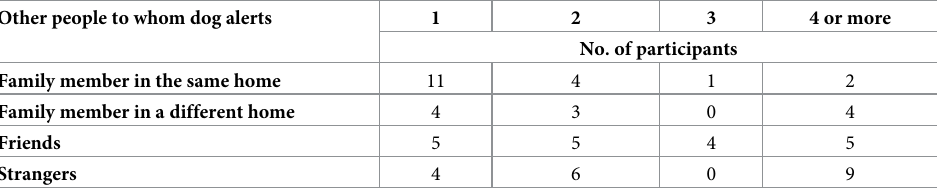
hyperglycaemia, p = .172, migraine, p = .270, seizure, p = .526, and POTS, p = .1.000). Further- more, additional Fisher’s Exact Tests with a Sˇida´k correction for multiple comparisons revealed no associations between the sociodemographic variables and whether or not a dog alerts to both other conditions and to people other than the target person (see supplementary materials). Table 6. The number of participants that reported that their dog alerted to 1, 2, 3, or 4 or more people other than the target person. Other people to whom dog alerts